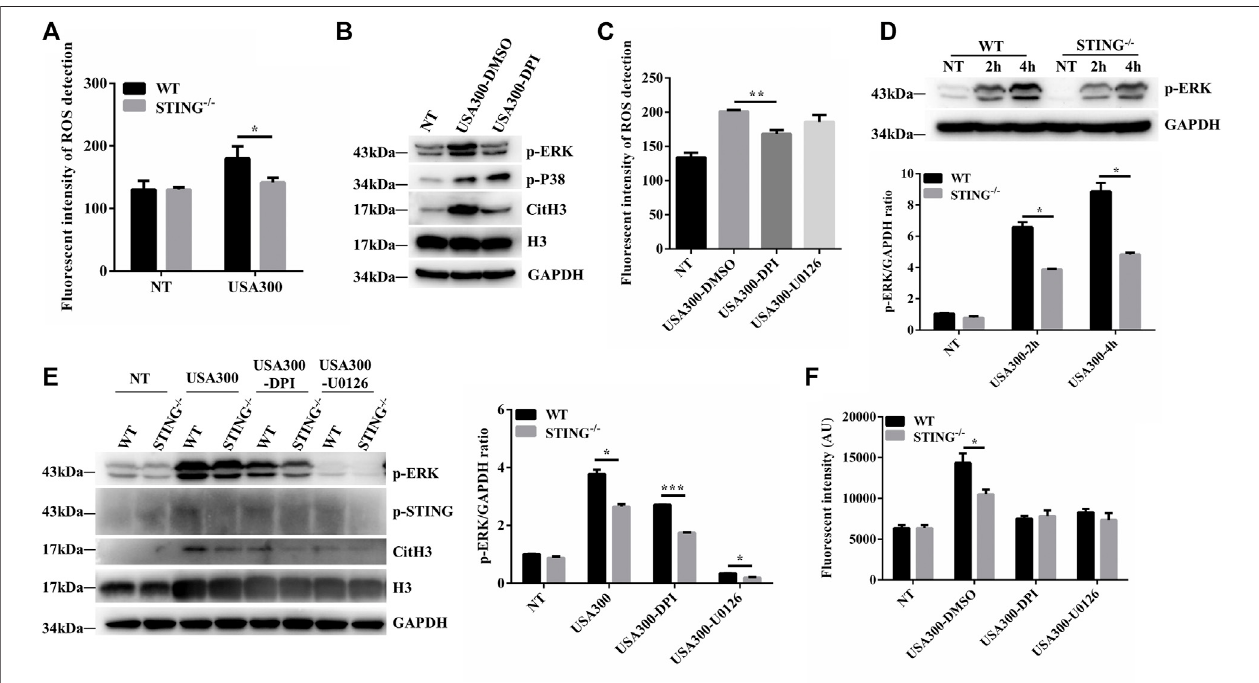
FIGURE4| STINGpromotesETsformationinaROS-ERK-dependentmannerupon S.aureus challenge. (A) MeasurementofROSproductioninBMDMsfromWT and STING -/- mice afterinfection with S.aureus (MOI: 20)for3 h (B) WT BMDMs werepretreated withDPI(10 μ M),andthecellswerethen infected with S.aureus (MOI: 20)for3 h.Wholecelllysateswereanalyzedforp-ERK,p-P38, CitH3,H3,andGAPDHbyWesternblotting. (C) WTBMDMswerepretreated withDPI(10 μ M)orU0126 (10 μ M) for 1 h before S. aureus (MOI: 20) treatment for 3 h. ROS production was detected by DCFH-DA. (D) BMDMs from WT and STING -/- mice were infected with S. aureus (MOI: 20) at the designed time points. Whole cell lysates were analyzed for p-ERK and GAPDH by Western blotting, and the gray intensity value was calculatedusingImageJsoftware.WTand STING -/- BMDMswerepretreated withDPI(10 μ M)orU0126(10 μ M)for1 hbefore S.aureus (MOI:20)treatment for3 h. (E) Whole cell lysates were analyzed for p-ERK, CitH3, H3, p-STING, and GAPDH by Western blotting, and the gray intensity value of p-ERK was calculated using ImageJ software. (F) The cfDNA in supernatants was stained with SYTOX Green and analyzed on a fl uorescent reader. Data are shown as the mean ± SEM. Data were pooled from 3 independent experiments. Signi fi cance calculated using two-way ANOVA with Bonferroni ’ s multiple comparison test, * p <